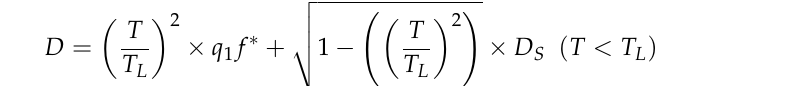
Figure 19. Shear damage and equivalent plastic strain diagram at different temperatures ( a – f ).